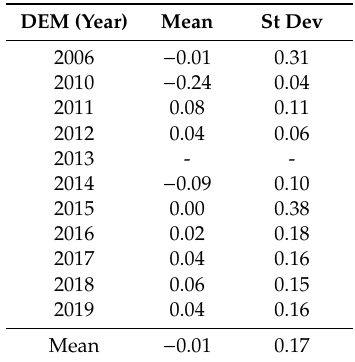
Figure 10. Comparison of the 2010–2019 average monthly Nivometric Coefficient (NC) calculated at the glacier’s mean elevation with the 50-year average between 1960 and 2009. Table 4. Accumulation and ablation season temperature and precipitation in the 2010–2019 decade, compared to the 50-year means. Rain and snow fractions of total precipitation are also compared. Temperature is extrapolated at the mean elevation of the Montasio Glacier applying monthly-variable gradients to the Pontebba weather station data. Precipitation data from the same station are not extrapolated at the glacier’s elevation, but are partitioned into liquid and solid fractions using extrapolated temperature.